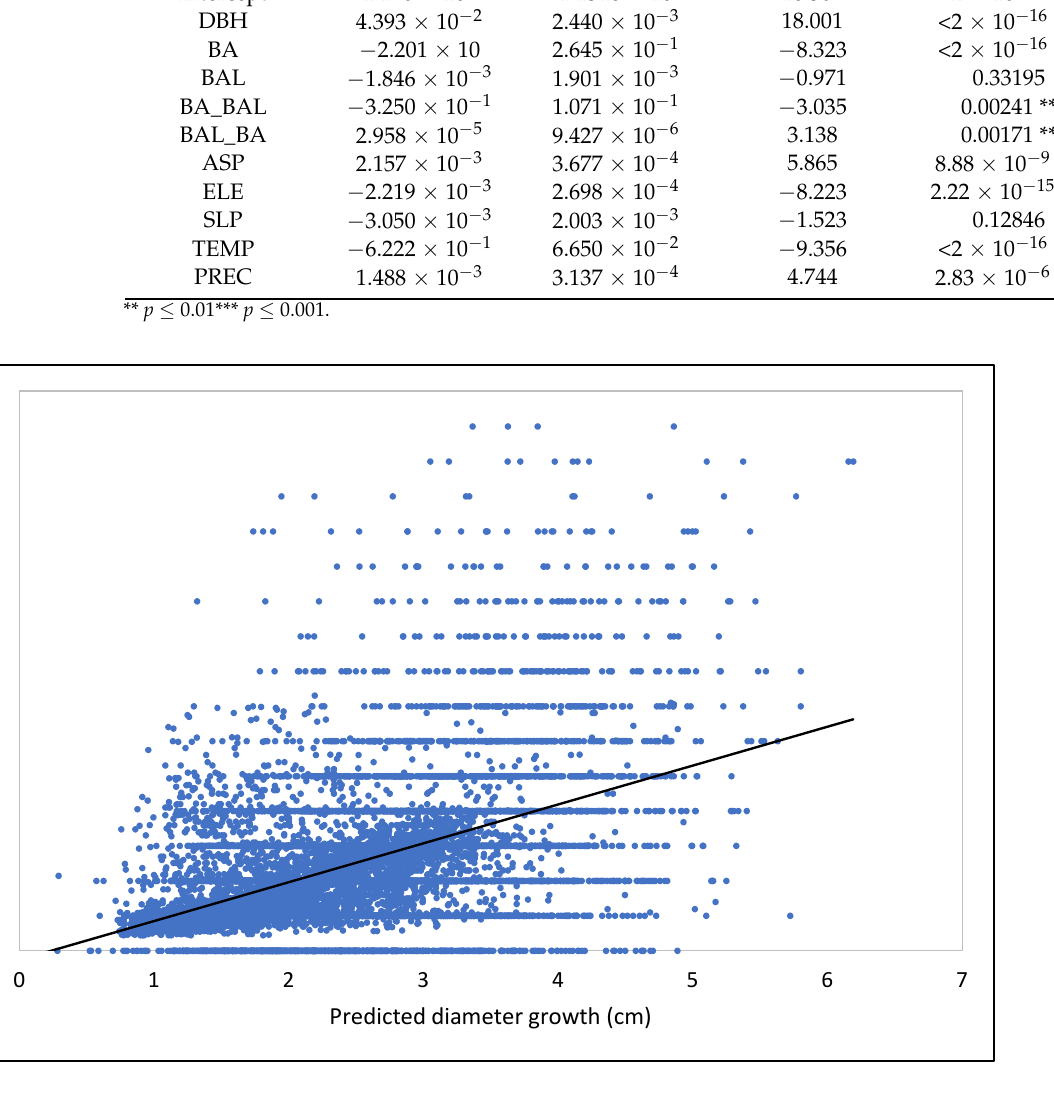
Figure 7. The relationship between predicted and actual diameter increment extracted by the mixed- effect